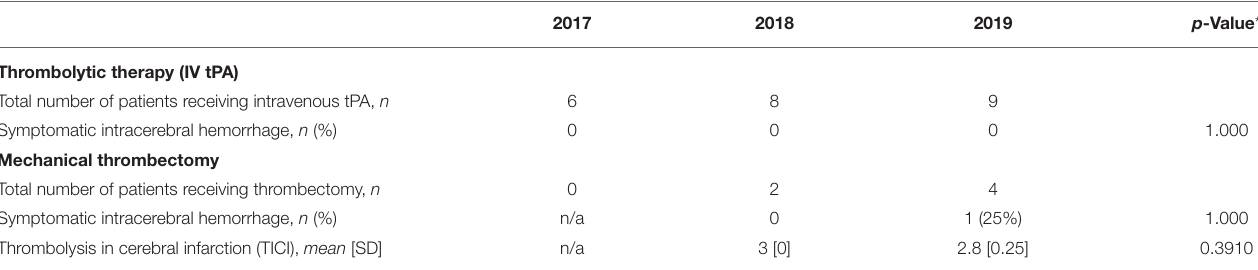
TABLE 3 | Acute stroke interventions.